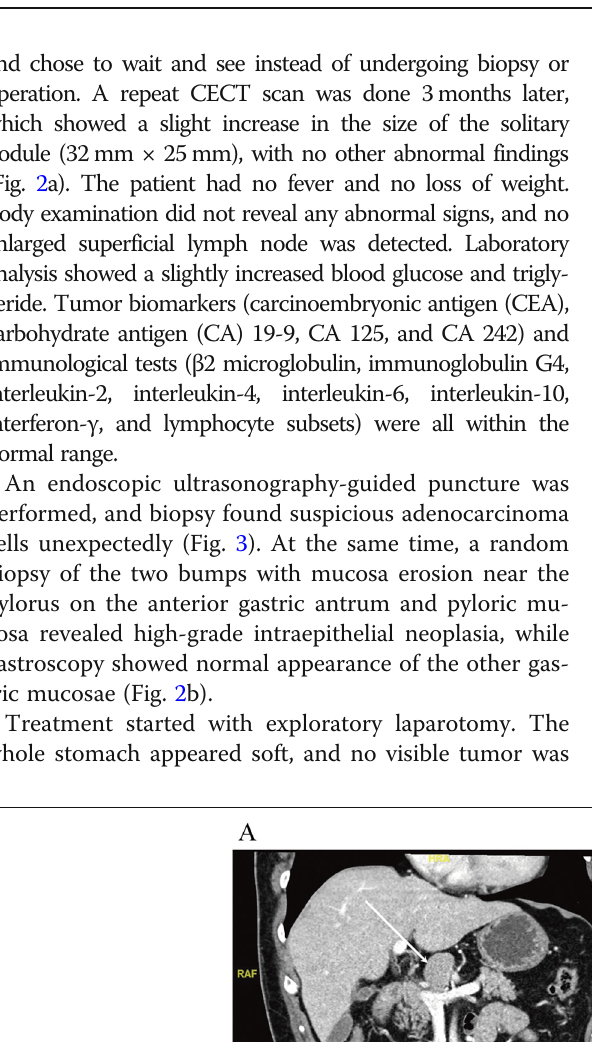
Fig. 1 The first preoperative tests. a The first gastroscopy that was taken at another hospital (scanned version of printed report). Slight superficial mucosal erosion of the gastric antrum. b The contrast-enhanced abdominal CT. A solitary nodule above the neck of the pancreas, size 29 mm × 27 mm, labeled by the white arrow